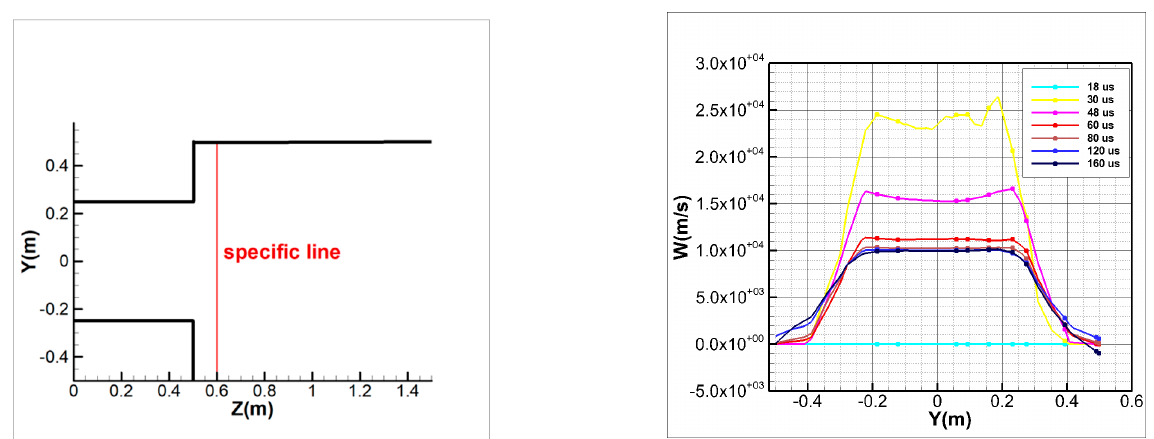
Figure 10. Variation curves of the z-direction velocity along the y-direction for a specific line.